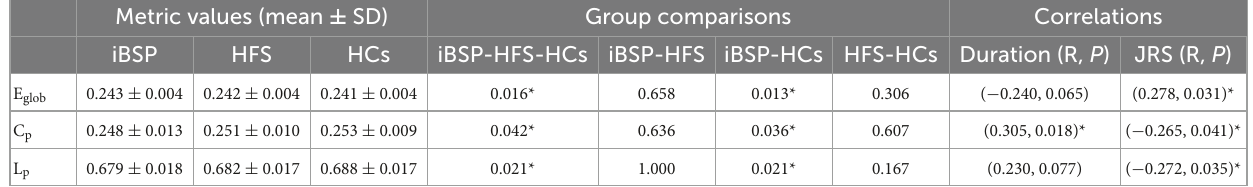
TABLE 2 Differences of network parameters among three groups and their relationships with clinical measurements in patients with iBSP.